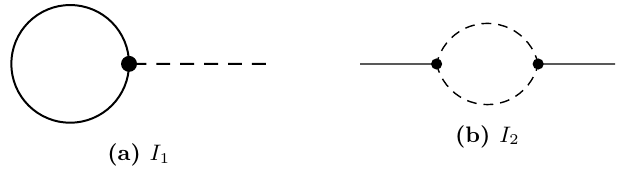
Figure 3. Master integrals for the boundary conditions. Solid and dashed lines correspond to massive and massless particles respectively. See appendix C for their explicit expressions